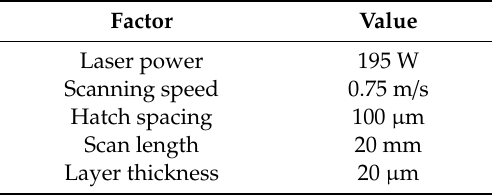
Table 1. Processing parameters in laser powder bed fusion (LPBF) of EOS GP1 stainless steel powder.